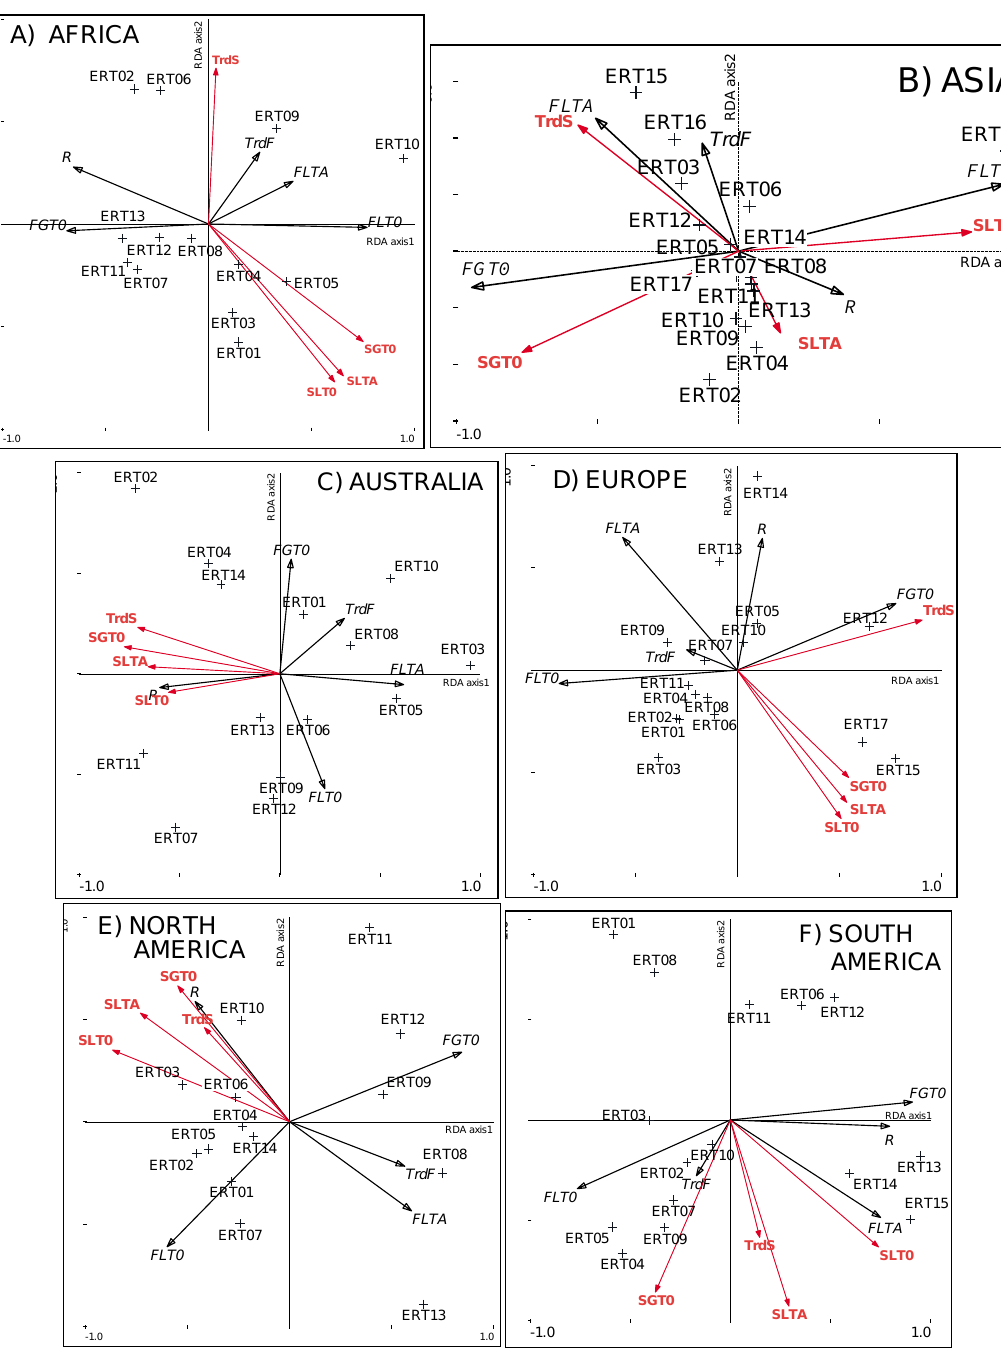
Figure 3. Redundancy analysis triplots. ERTs are represented with crosses, FPAR3g (F) variables with black arrows and the SPEI12 (S) variables with red arrows. LTA = Long Term Average; GT0 = positive anomalies; LT0 = negative anomalies; Trd = Thiel-Sen slopes; R = correlation between the FPAR3g and the ERTs average SPEI12 profile. ( A ) Africa, ( B ) Asia, ( C ) Australia, ( D ) Europe, ( E ) North America and ( F ) South